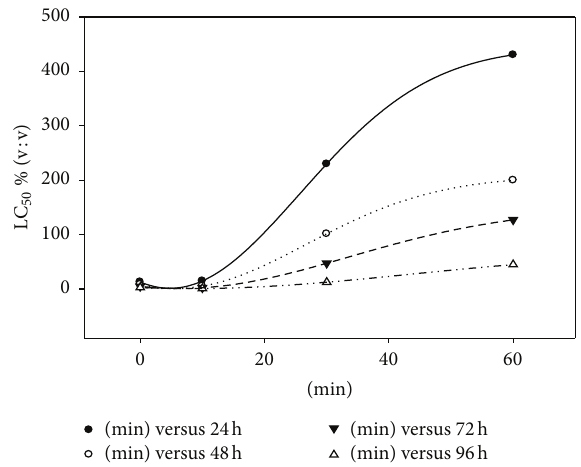
Figure 4: The change of LC 50 of treated phenolic stream versus = 200 mg/L; catalyst concentration reaction time of COP, [phenol] o of 2 g/L; initial pH of 8 :0.